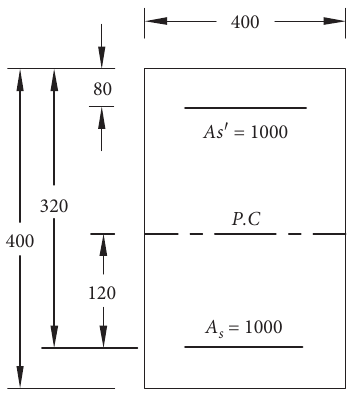
Figure 7: Column